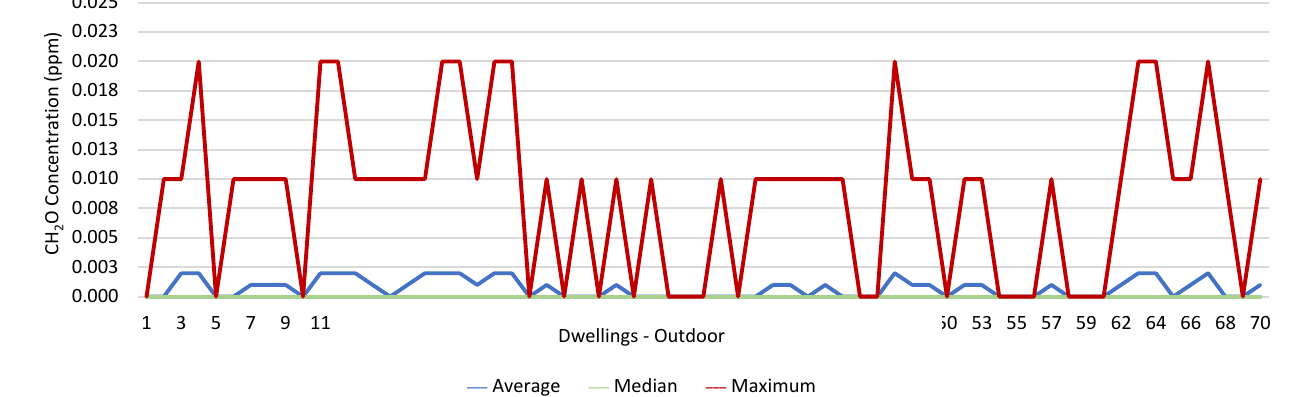
Figure 4. CH 2 O concentration (ppm) outdoors.